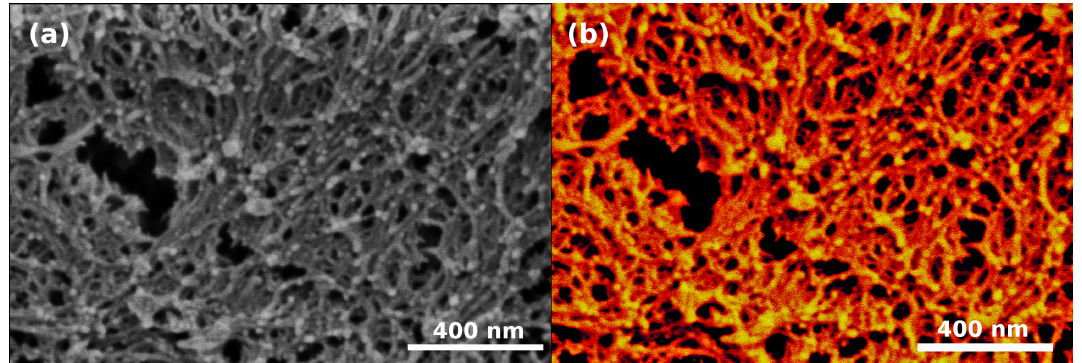
Figure 9. Images showing the combination of the as-obtained in-lens secondary electron (SE) and back scattered electron (BSE) signals of the 32 nm sputter coated Ca-alginate sample. The contrast correlates with atomic number: brighter regions correspond to higher atomic numbers. The aerogel consists of low atomic number elements, the bright spots are Au particles. The two images are identical, displayed in different color planes: ( a ) black/white and ( b )